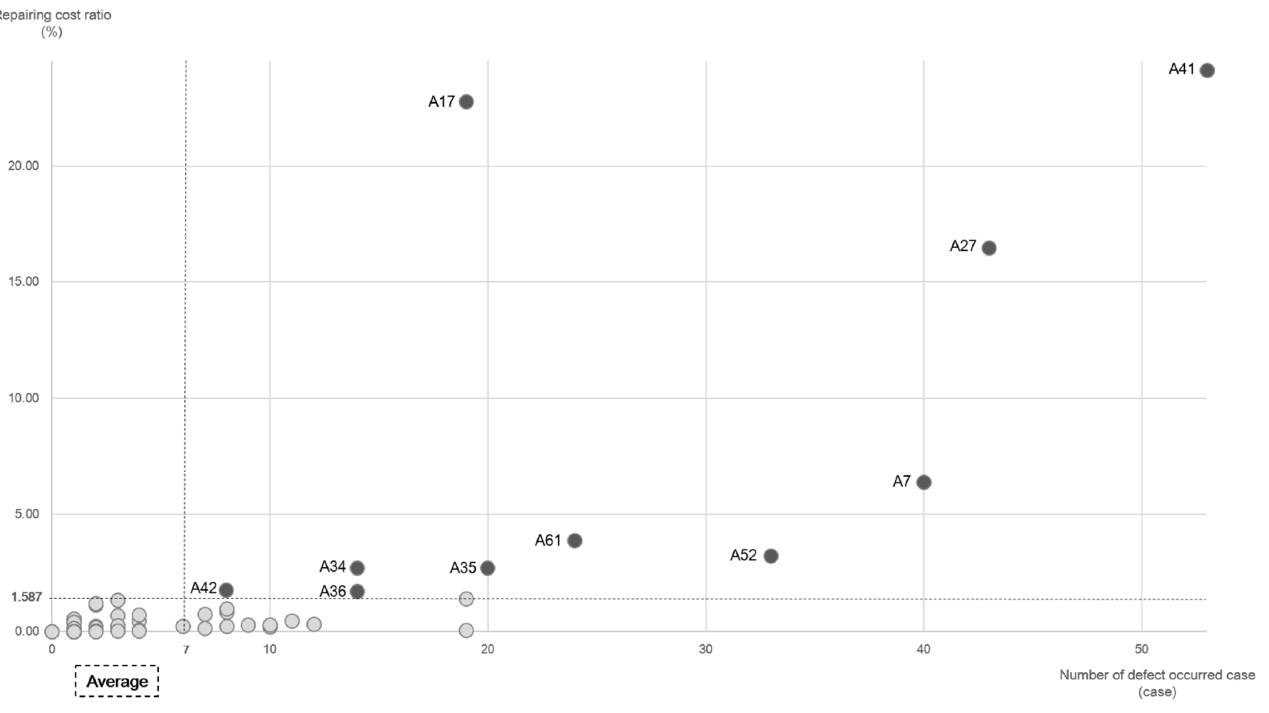
Figure 3. Comparison between defect occurrence and repair cost ratio.